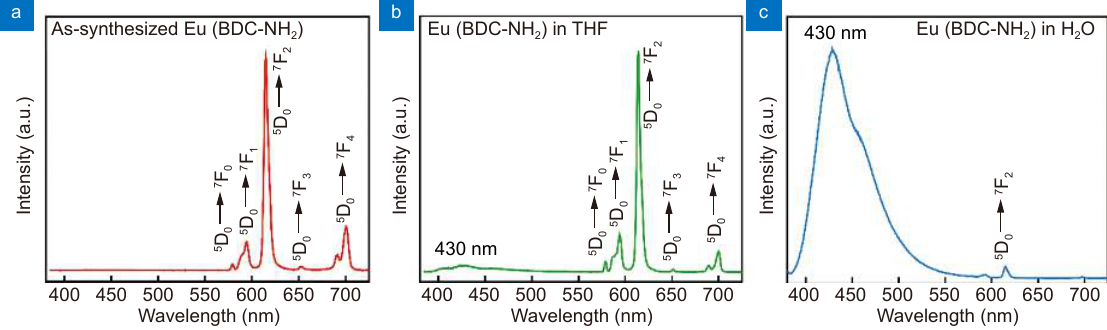
Fig. 3 | Emission spectra of Eu(BDC-NH 2 ) in the solid state ( a ) suspended in THF ( b ) and in water ( c ) excited at 375